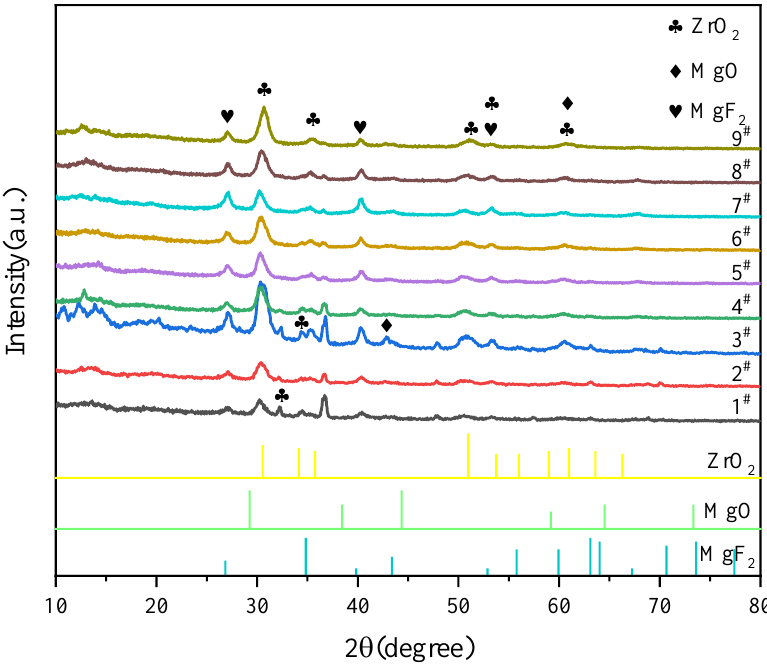
Figure 7. XRD patterns of MAO coatings from orthogonal experiment.